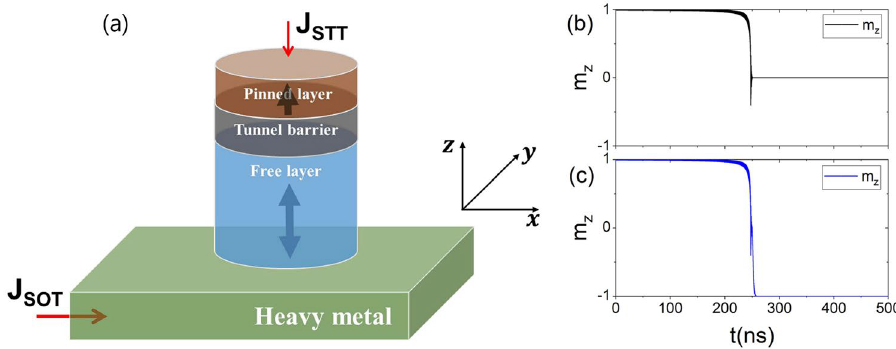
Figure 1. ( a ) Schematic of STT-SOT hybrid switching of MTJ with shape perpendicular magnetic anisotropy. The current flowing through the heavy metal (MTJ) induces the spin current by the spin-orbit effect (spin filtering effect). The combination of STT and SOT enables the deterministic switching of magnetization of the free layer. The method of STT-SOT hybrid switching of MTJ with S-PMA ensures the magnetization switching at lower current density and high thermal stability at sub-20 nm. ( b , c ) The magnetization dynamics of MTJ when J SOT = 6.0 × 10 12 A/m 2 and J STT = 2.2 × 10 11 A/m 2 . ( b ) Continuous application of the current inducing the STT and SOT. ( c ) Turning off the current-induced SOT approximately 250